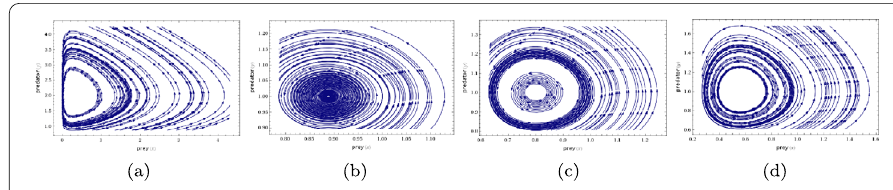
Figure 1 Solutions of (7) for different values of σ (1 – μ ). Fig. 1( a ) and Fig. 1( c ) are the solutions for ( κ